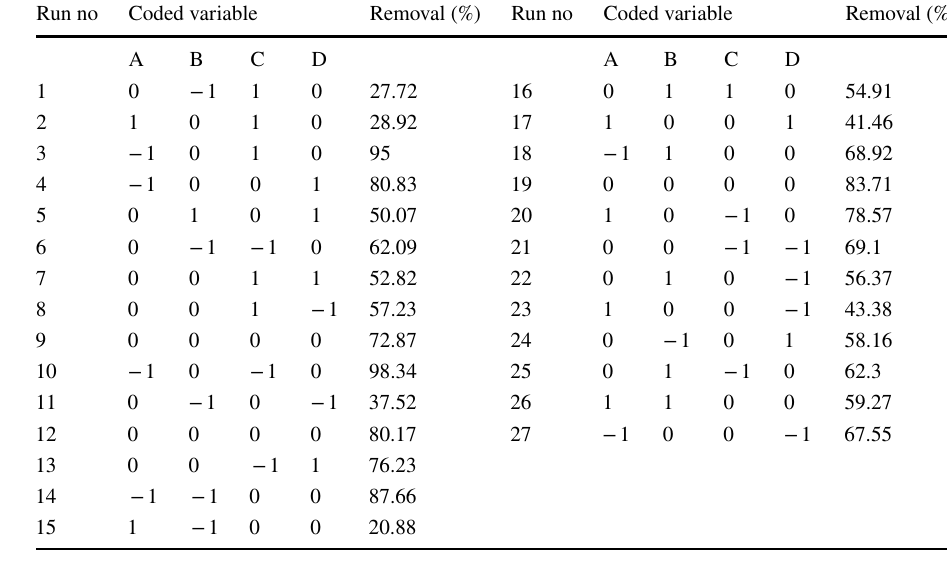
Table 2 BBD matrix for RR-141 removal using γ-Al 2 O 3 NPs